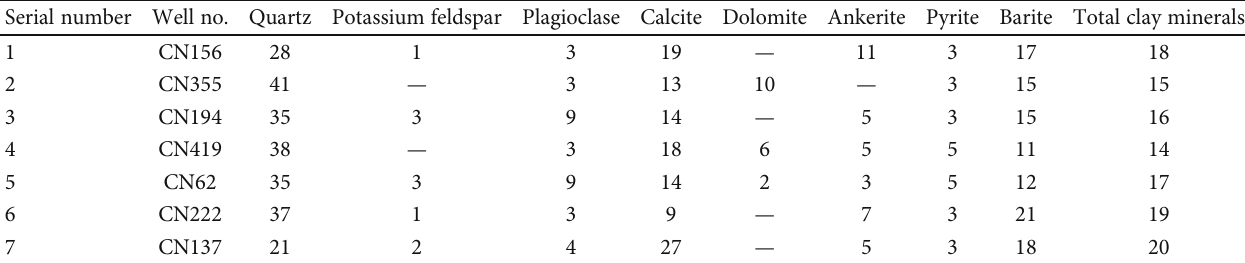
Table 2: Total mineral component analysis of rock samples in the Longmaxi and Wufeng Formations.